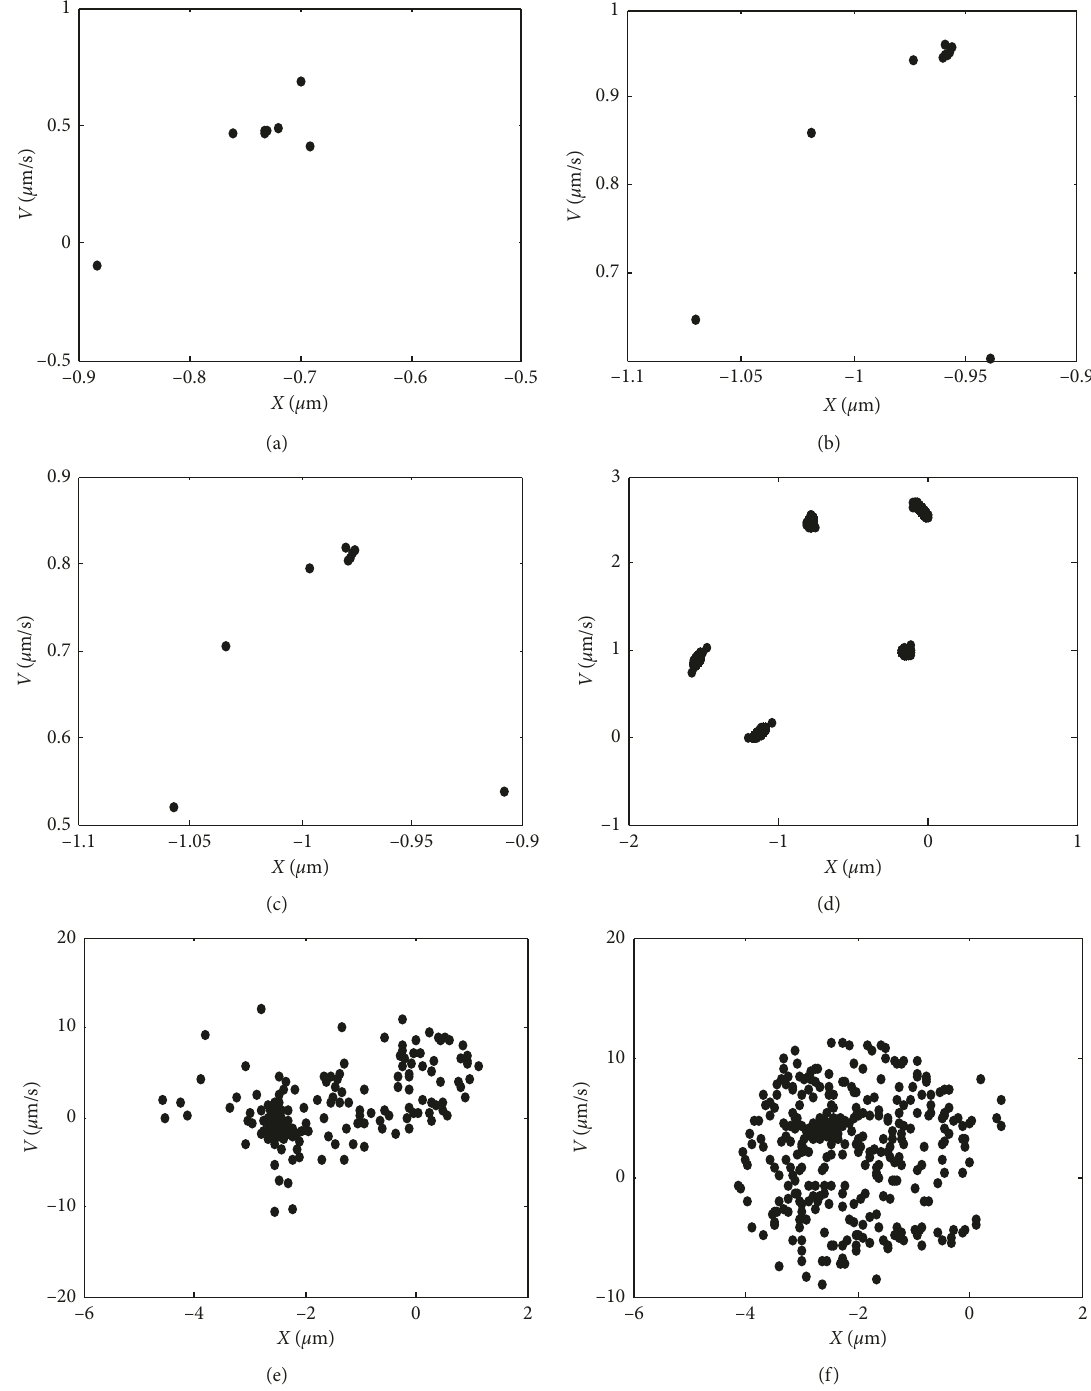
Figure 8: Poincar´e map. (a) P � 20, (b) P � 100, (c) P � 260, (d) P � 450, (e) P � 600, and (f) P �